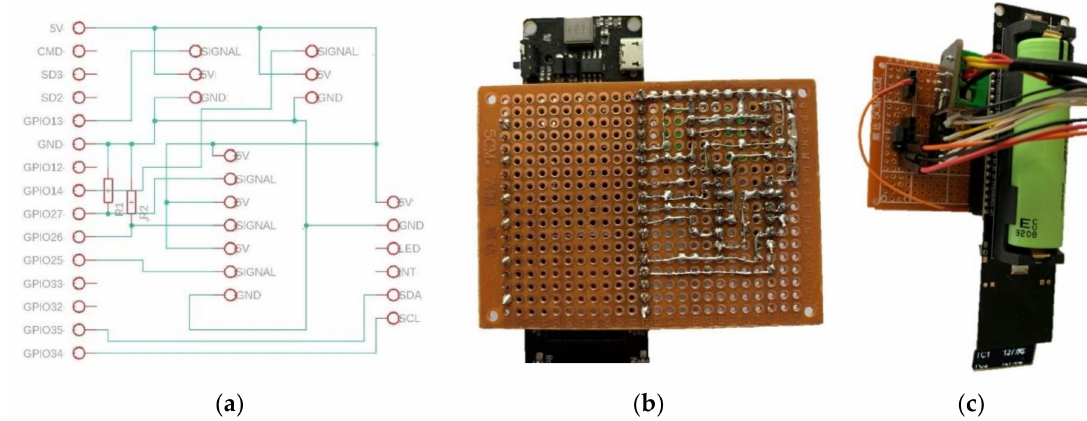
Figure 12. Schematic design of the electronic board for the sensors ( a ), soldering process ( b ) and electronic assembly ( c